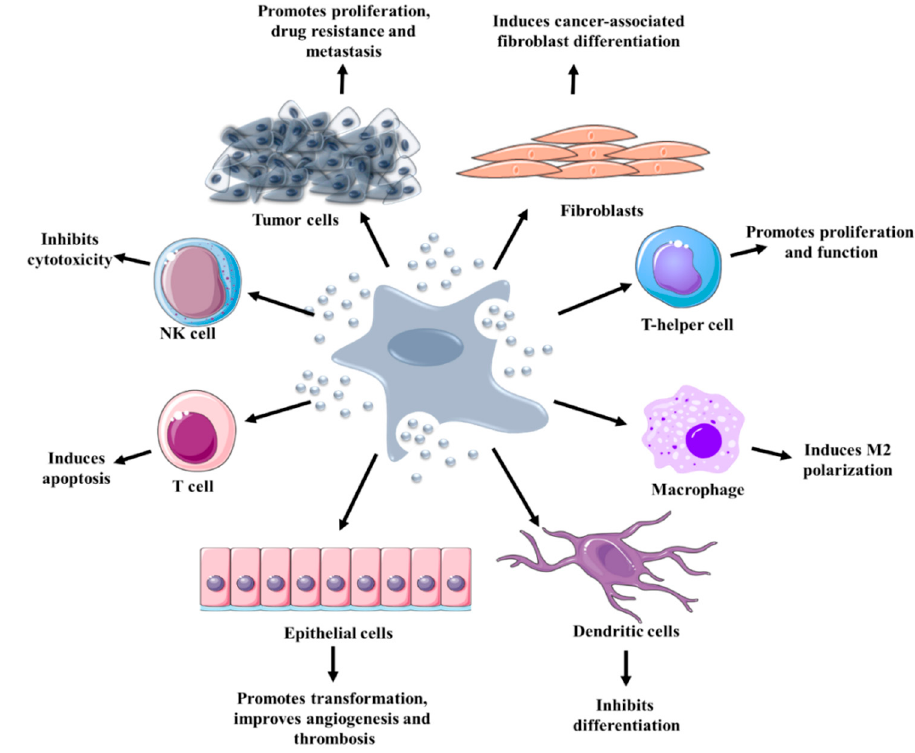
Figure 6. An overview of EV functions in TME cooperation. EVs derived from tumor cells act in an autocrine and paracrine manner. The interaction between tumor cells and other cells of TME through EVs may result in proliferation, tumor growth, metastasis, and drug resistance. EVs derived from tumor cells are involved in macrophage polarization, immune suppression, the transformation of fibroblast to cancer-associated fibroblasts, metastasis, induce cell death, enhanced angiogenesis, drug resistance.